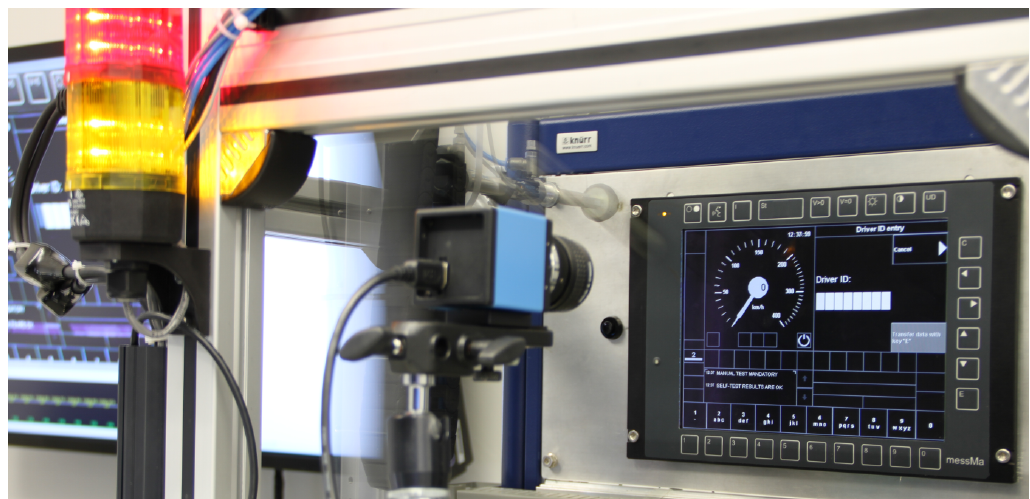
Figure 5: Automatic operation of DMI by